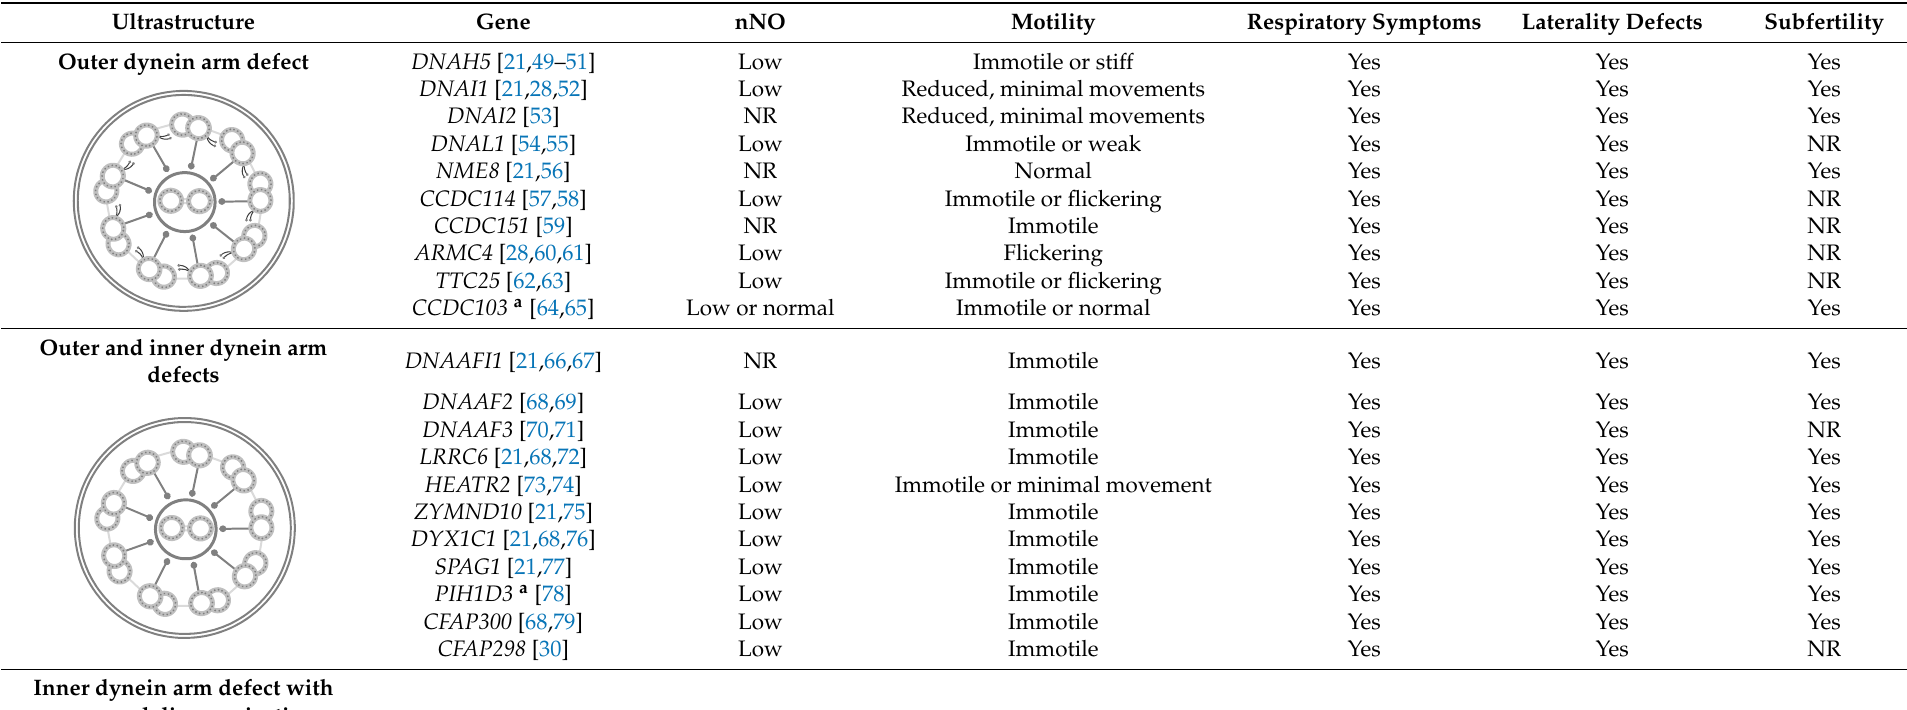
Table 2. The relationship between specific genes, ultrastructural defects, other diagnostic measures, and clinical features in primary ciliary dyskinesia.